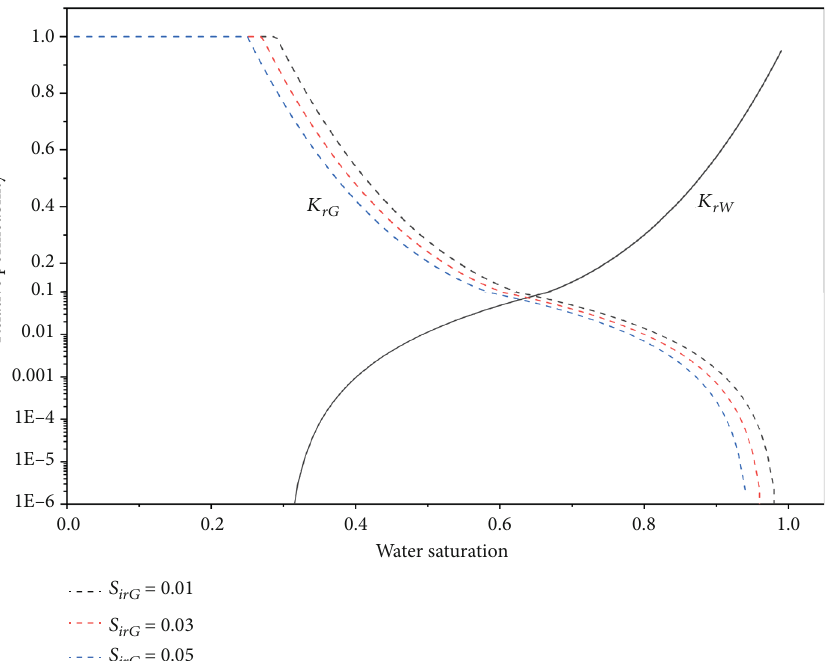
Figure 11: Relationship between gas, water relative permeability, and water saturation under di ff erent irreducible gas saturation.